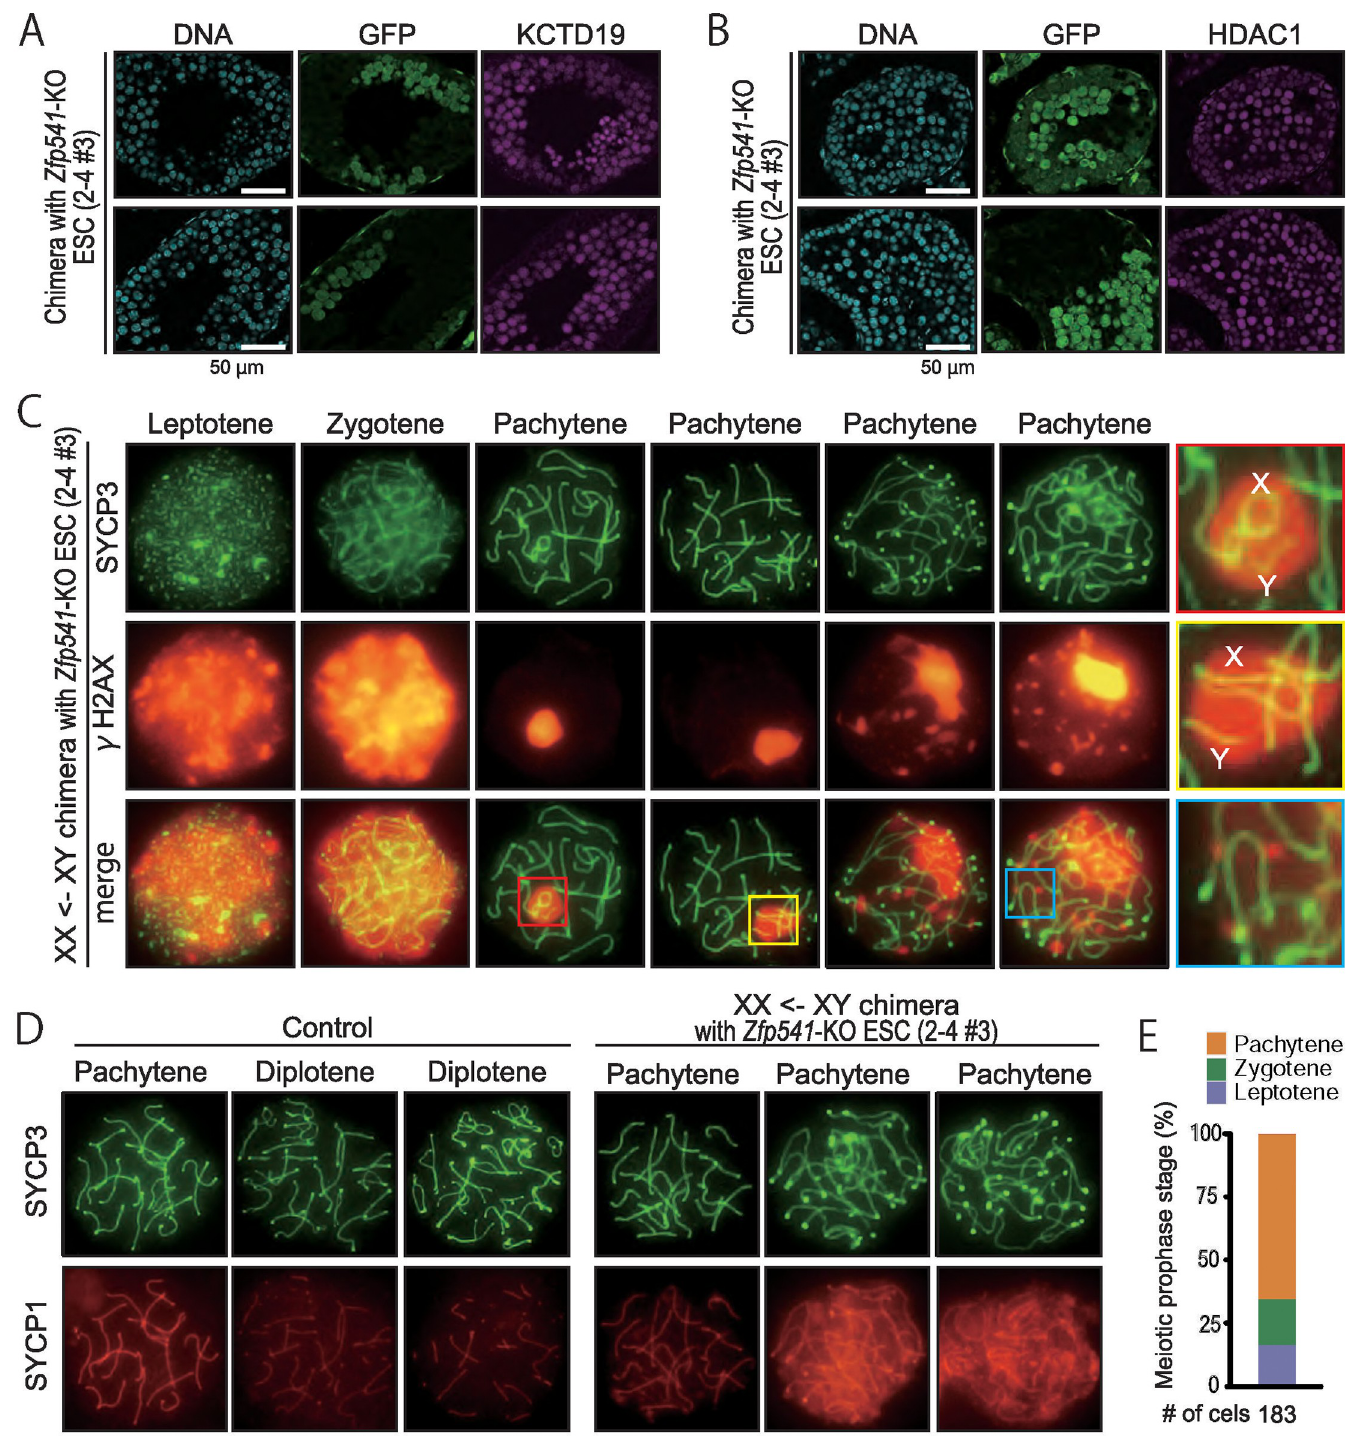
Fig 7. Immunostaining analysis of Zfp541 KO spermatocytes. (A and B) Immunostaining of seminiferous tubules of chimeric mice with antibodies against KCTD19 (A) and HDAC1 (B). ES cell-derived Zfp541 -KO spermatocytes were identified by GFP immunostaining. (C) Immunostaining of spread nuclei of prophase spermatocytes collected from XY/XX chimeric mice. Red, yellow, and blue boxes are magnified in the right panels. (D) Immunostaining of spread nuclei with anti- SYCP1 and anti-SYCP3 antibodies. Kctd19 we/del spermatocytes was used as control. (E) The percentage of cells in various meiotic prophase stages counted from immunostained spread nuclei